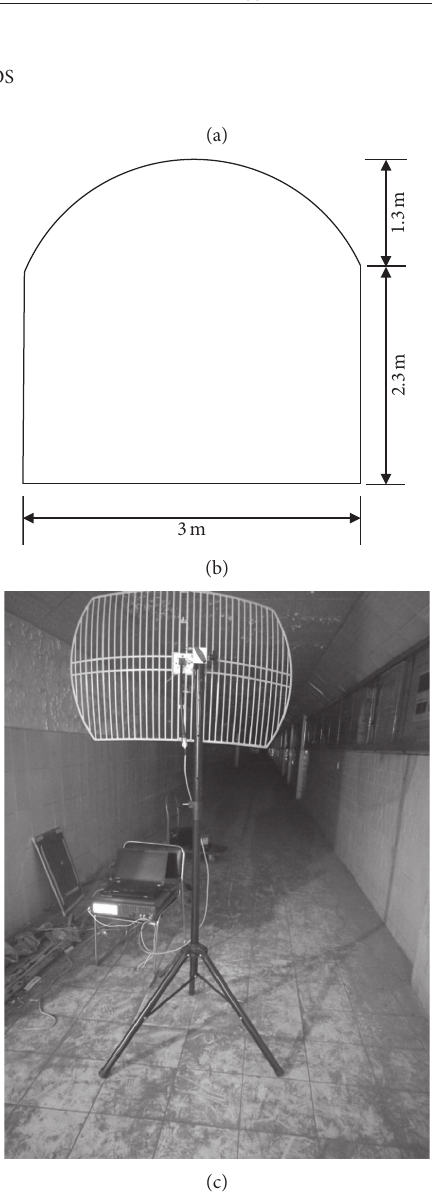
Figure 3: Measurement environment: (a) schematic; (b) arched cross section; (c) measurement